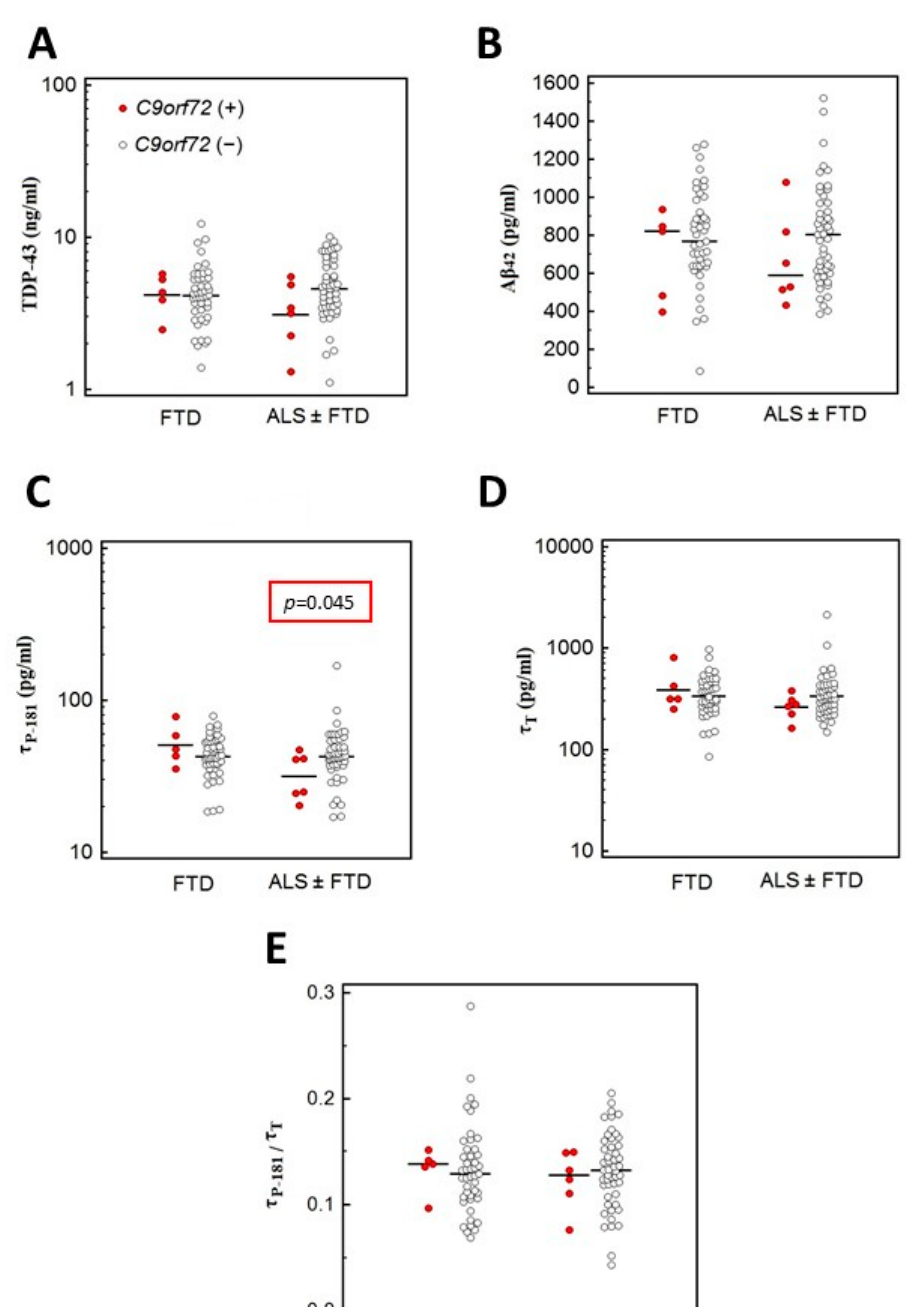
Figure 2. Comparison of TDP-43 ( A ); A β -42 ( B ); τ P-181 ( C ) and τ T ( D ) levels and τ P-181 / τ T ratio ( E ) in C9orf72 hexanucleotide repeat expansion carriers ( C9orf72 +) and non-carriers ( C9orf72 − ). Analyses were performed separately for FTD patients and ALS (with or without FTD) patients. In patients with ALS (with or without concurrent FTD), levels of τ P-181 were lower in C9orf72 carriers compared to non-carriers (C). All other comparisons yielded non-significant results.